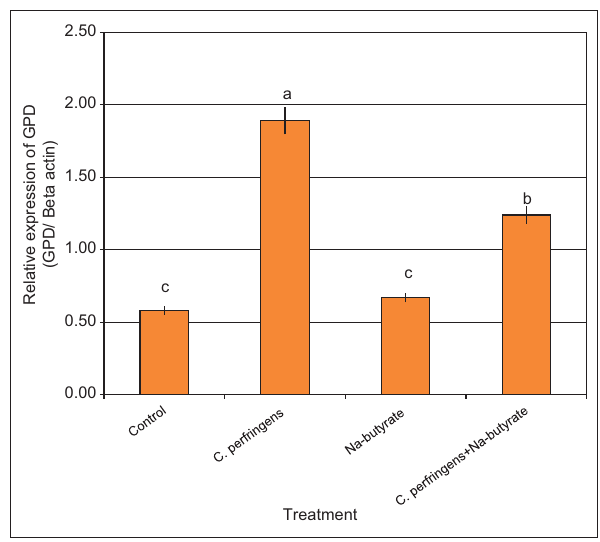
Figure-3: Semi-quantitative real time-polymerase chain reaction analysis of GPD-mRNAs in bursa tissues collected from chickens infected with C. perfringens and/ or Na-butyrate. a,b,c Means with different letters, differ significantly (p ≤ 0.05).